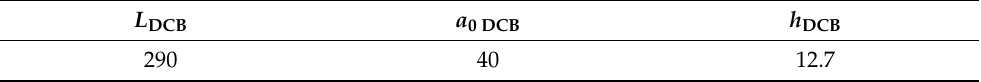
Table 5. Base geometrical parameters of the DCB specimen. Dimensions in millimetres. L